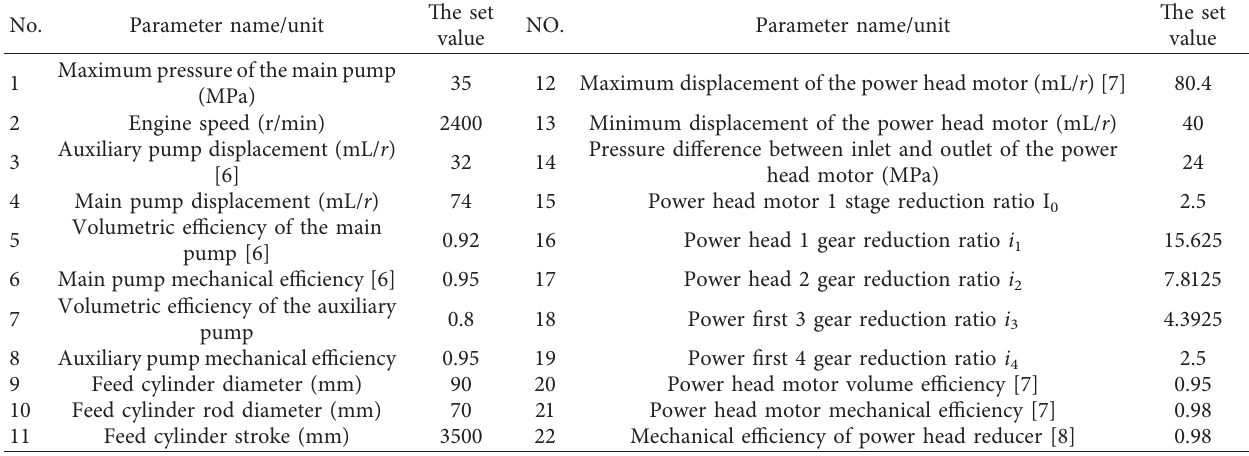
Table 1: Simulation boundary parameters of the hydraulic system of the geological drilling